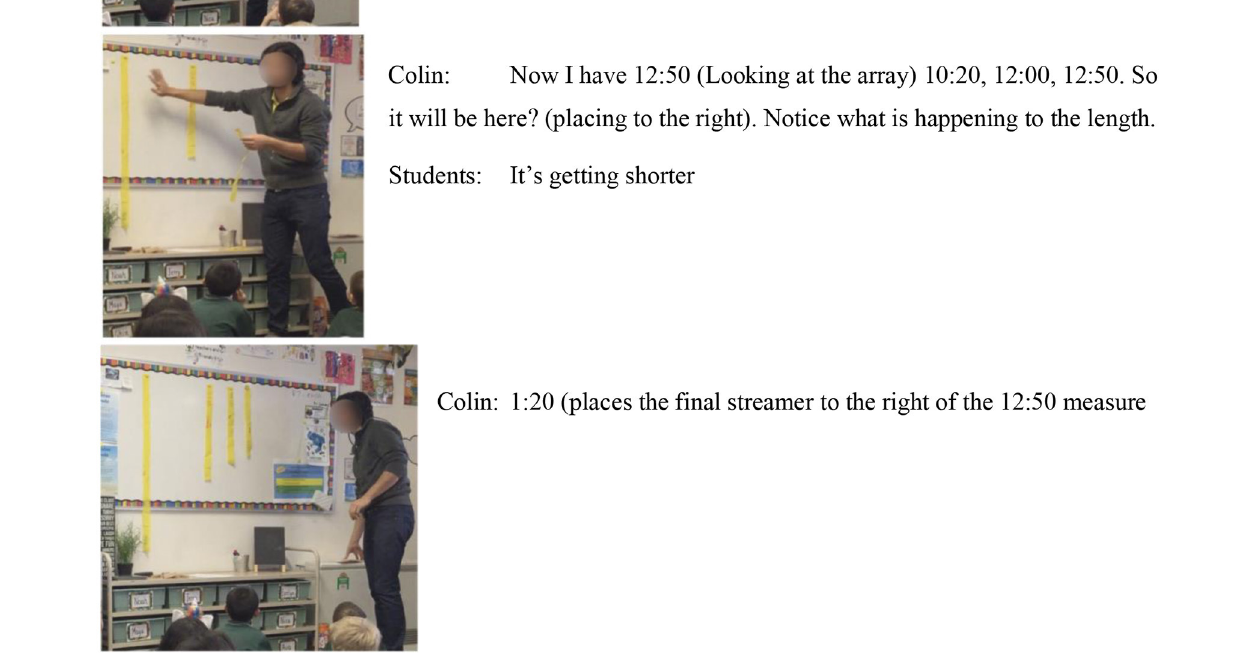
FIGURE 9 | Colin ordering streamers in a temporal sequence.